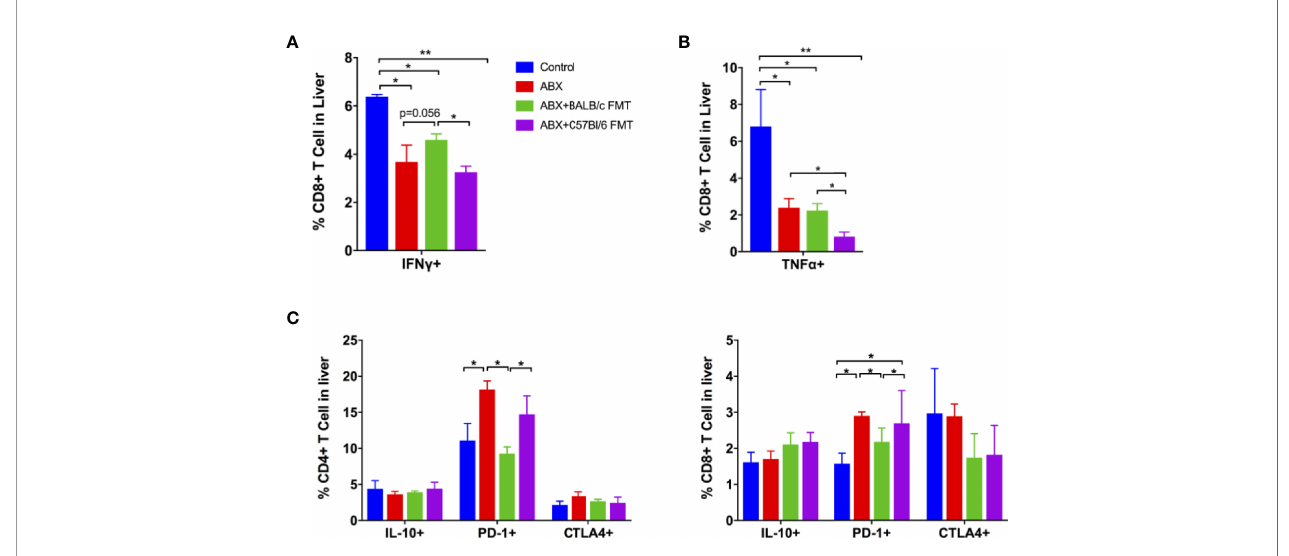
FIGURE 9 | ABX treatment and FMT regulate the T-cell response to HBV infection. Lymphocytes were isolated from the liver at 42 dpi and stimulated with a CD8+ T-cell epitope. The expression of intracellular IFN g (A) and TNF a (B) on CD8+ cells was measured by FACS. (C) The expression of intracellular IL-10, surface PD-1, and CTLA-4 on non-stimulated CD4+ and CD8+ T cells was measured by FACS. n = 10/group. * P < 0.05, ** P <